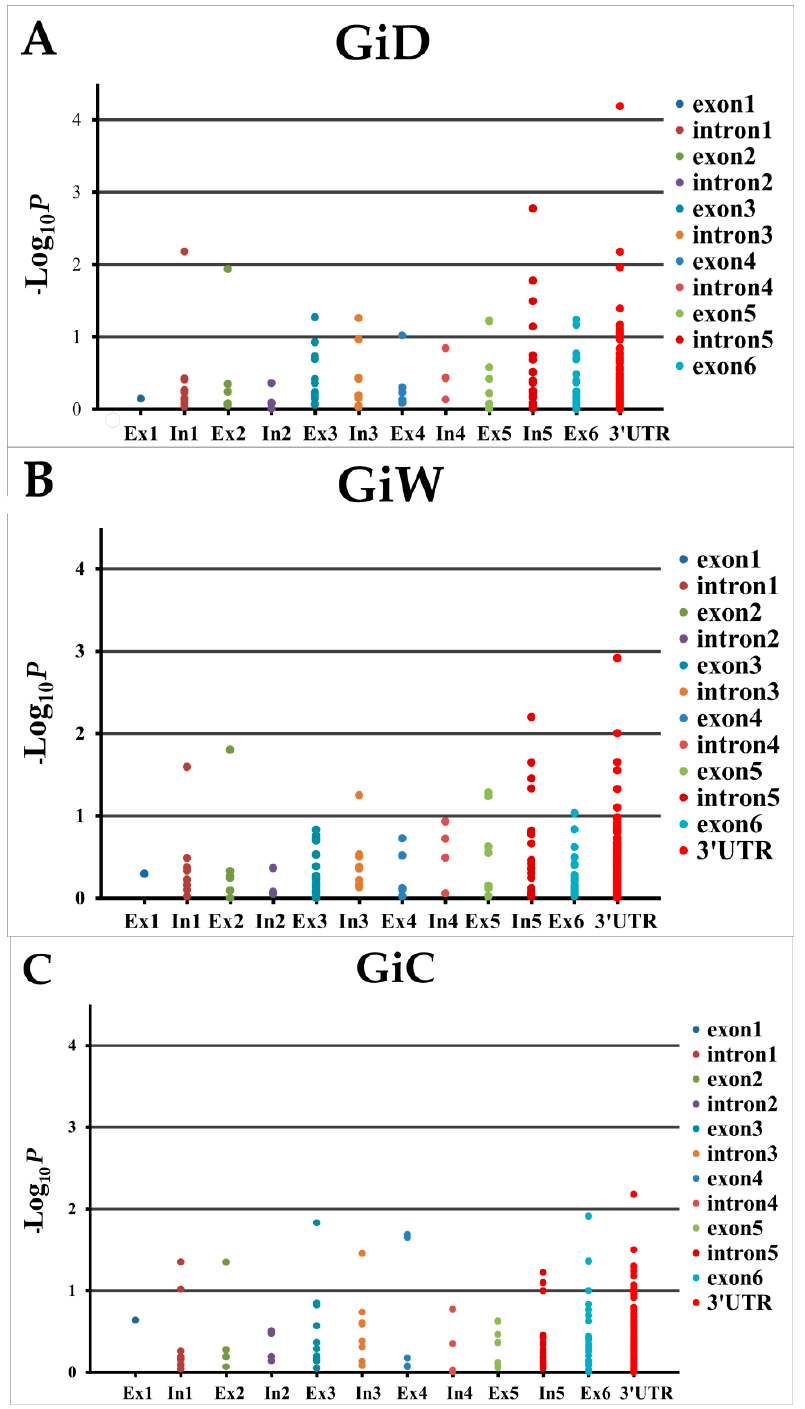
Figure 3. Marker–trait associations across the COBL gene. Associations were based on FarmCPU. The p-value of the marker is given at each position ( p -value was decimal log transformed). ( A ) girth in the dry season (GiD), ( B ) girth in the wet season (GiW), and ( C ) total girth increment (GiC).